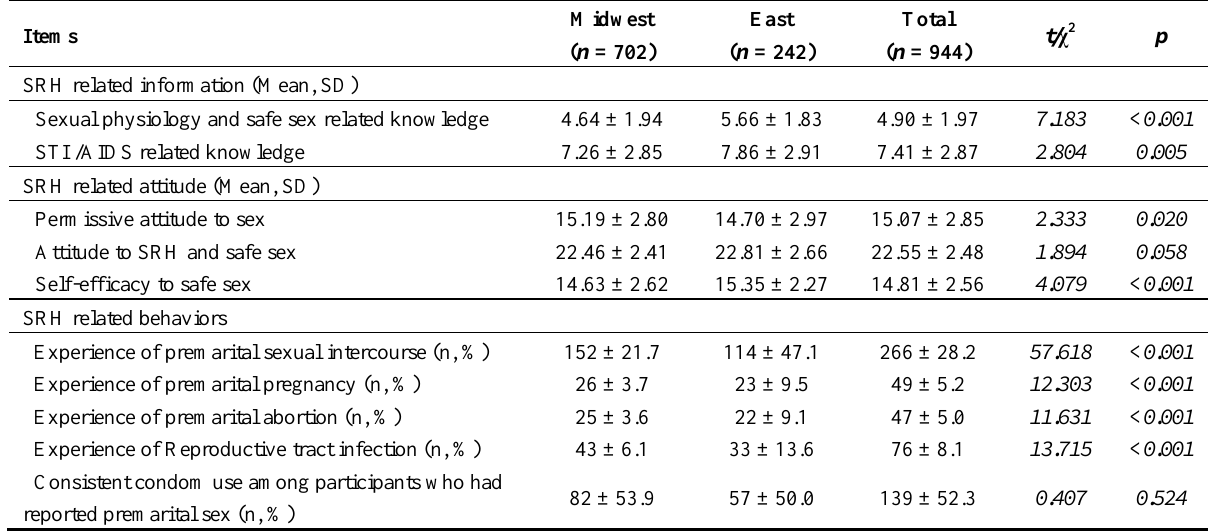
Table 2. Comparison of SRH related information, attitude, and behaviors among unmarried rural-urban female migrants from mid-west and east China.